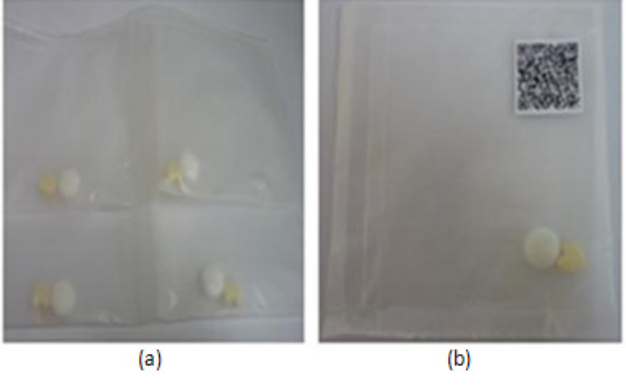
Figure 9. Sample medicine packs in Korea: ( a ) Medicine packs; ( b ) Medicine pack with